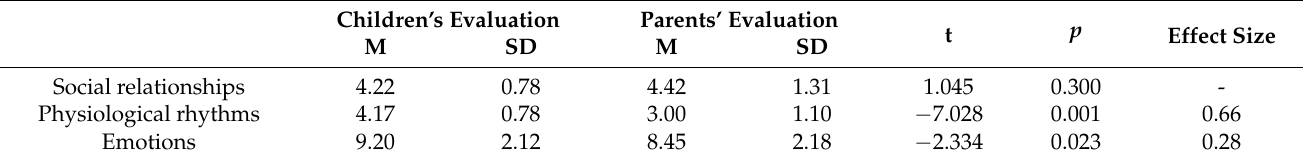
Table 4. Differences between children’s and parents’ evaluation of the impact of the pandemic on